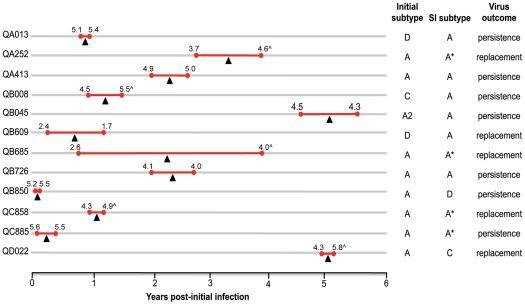
Viral characteristics of 12 cases of SI.Subject IDs are shown to the left with time since initial infection plotted at the bottom. Red bars denote the interval during which SI occurred, with closed circles representing the last time point in which SI was last undetected and the time point at which SI was first detected. Black triangles mark the midpoint of this interval, which was used as the estimated time of the SI event. The individual's viral load (log10 copies/ml) at the corresponding time points is noted above each red bar, with (∧) denoting increases in viral load >0.5 log10 copies/ml. Subtyping in the two columns on the right are based on env sequences. However, the data for those individuals with an (*) by their superinfecting virus subtype based on gag sequences alone as the superinfecting env sequence was not detected at time points tested. Virus outcome was based on the longitudinal analyses previously described [20]–[22]. Persistence was defined as the detection of co-existence of the superinfecting virus with the initial virus following its introduction, while we classified replacement superinfections as the dominance of the superinfecting virus based on lack of detection of the initial virus post-SI [22].